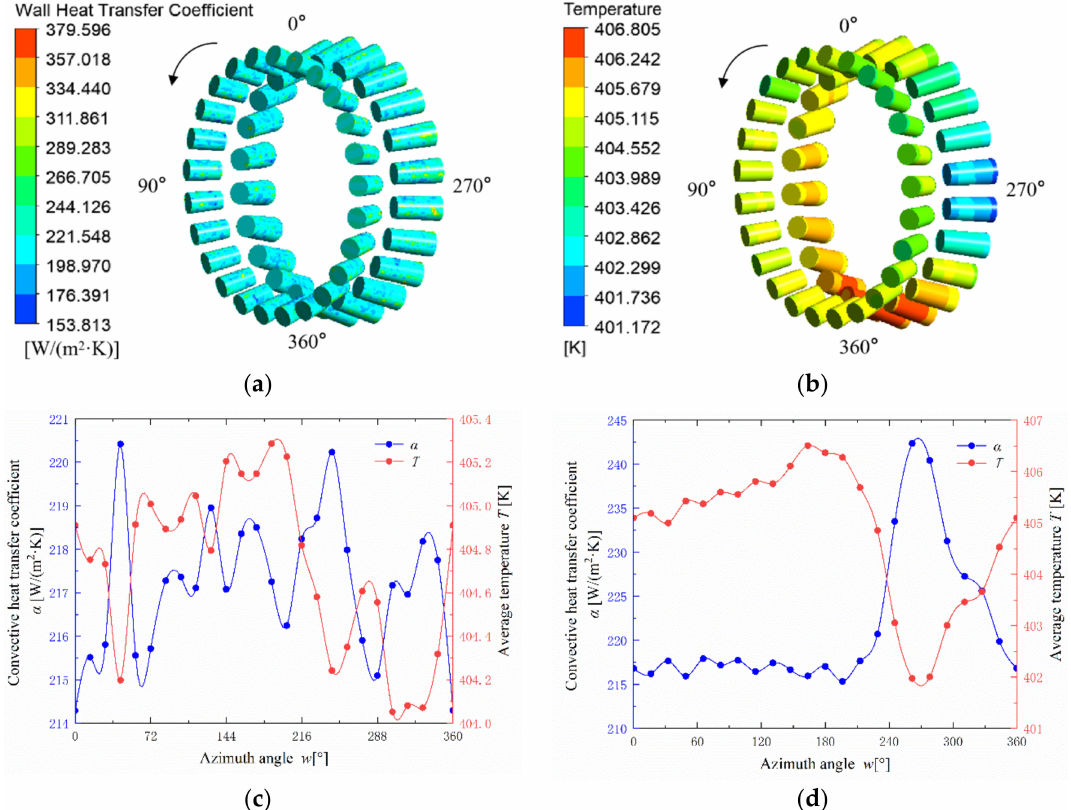
Figure 18. Temperature characteristics of bearing rollers: ( a ) convective heat transfer coefficient of rollers; ( b ) temperature of rollers; ( c ) temperature characteristics of small rollers; ( d ) temperature characteristics of big